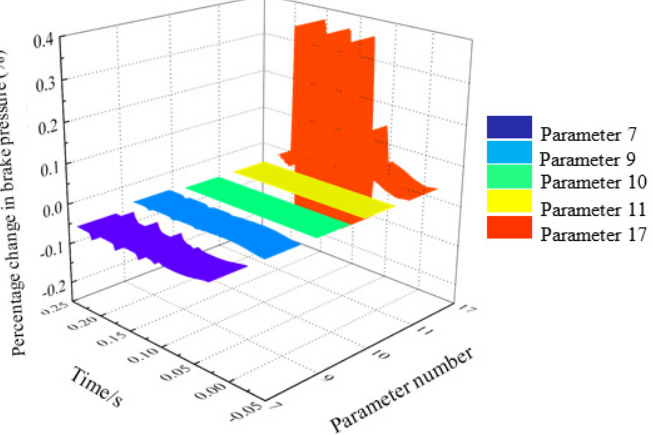
Figure 8. The change of x 8 with feedback part parameter varieties by 10%.